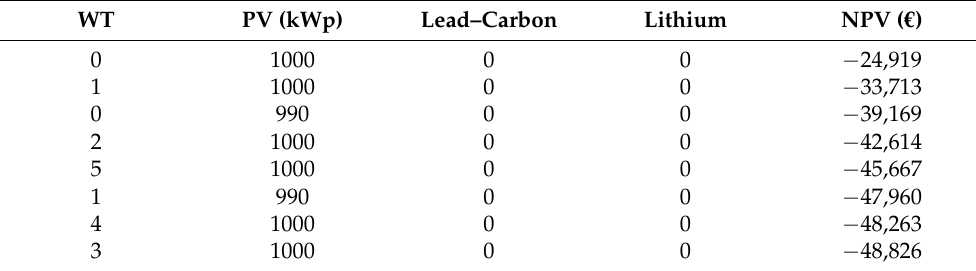
Table 2. Optimal results of the HMU campus microgrid for the autoproducer case. WT